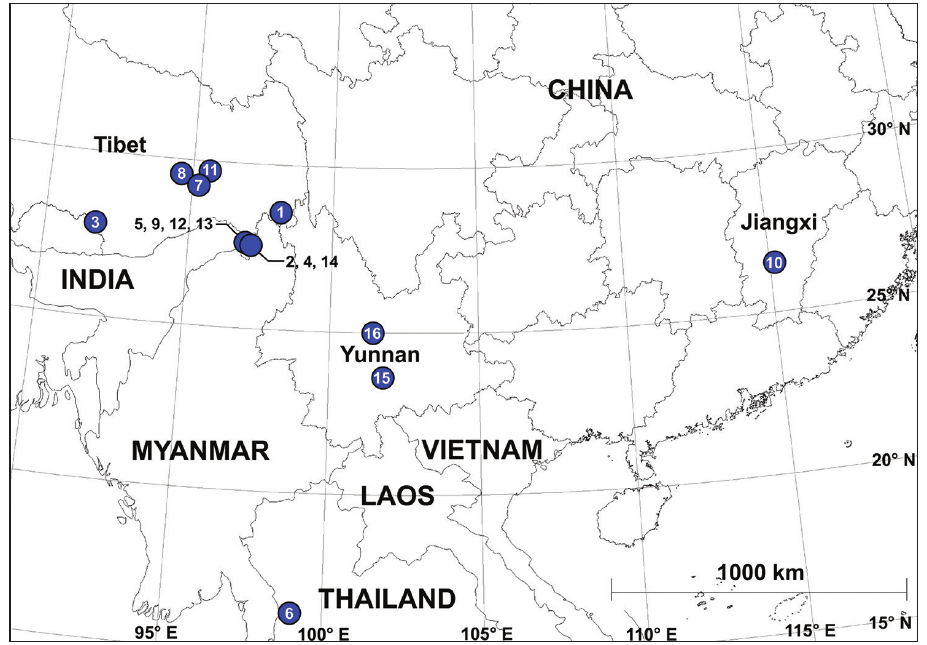
Figure 37. Distribution map of the sixteen new species from the genus Pseudopoda . The numbers represent the different species 1 P. chayuensis Zhao & Li, sp. n. 2 P. colubrina Zhao & Li, sp. n. 3 P. conaensis Zhao